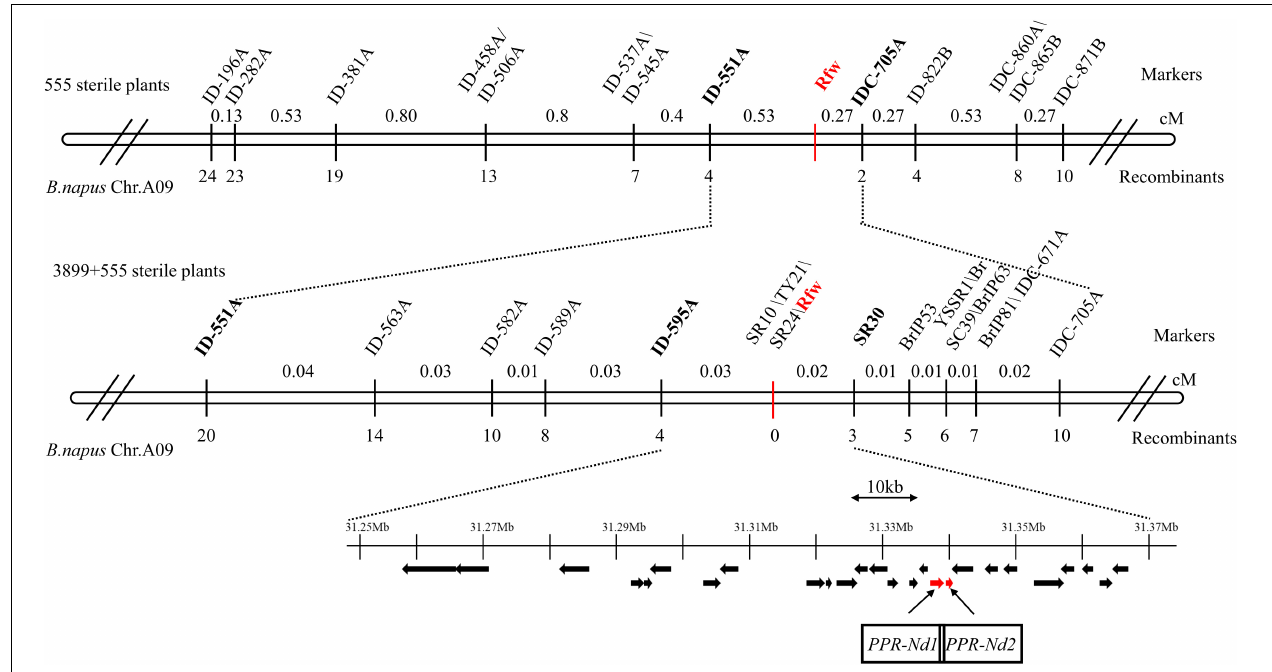
FIGURE 4 | Fine mapping of the Rfw locus in Brassica napus . The number below each marker indicates the number of recombinant plants (with respect to each given marker and the Rfw locus). Black arrows represent predicted genes in the 115.62 kb target region on chromosome A09 of B. napus . Red arrows indicate candidate Rfw